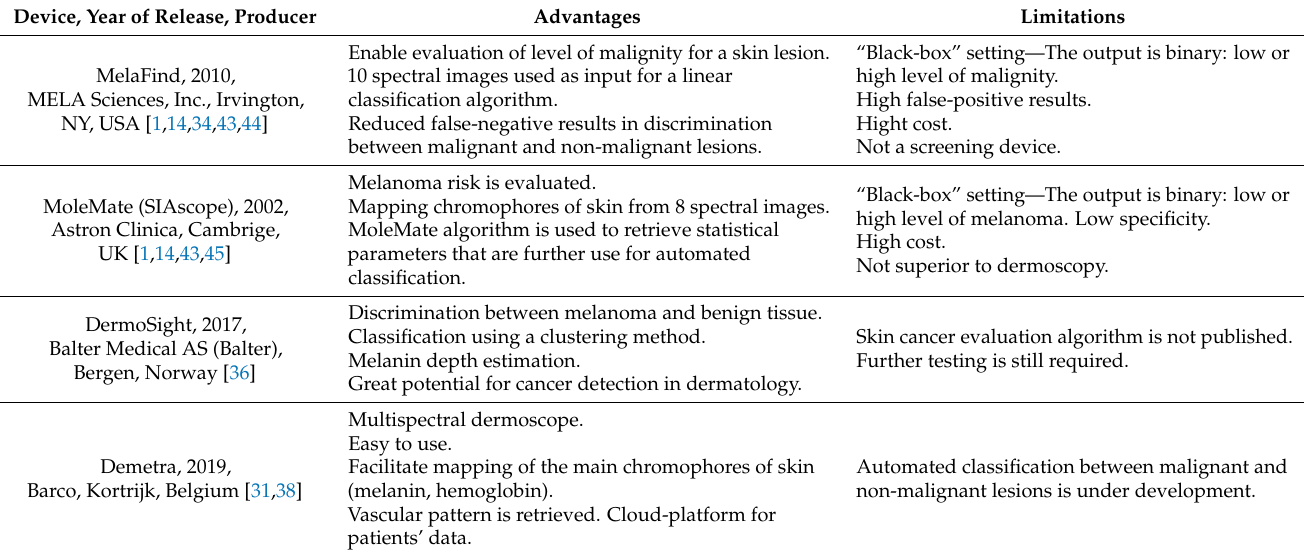
Table 3. Advantages and limitations of commercial MSI systems for dermatology.